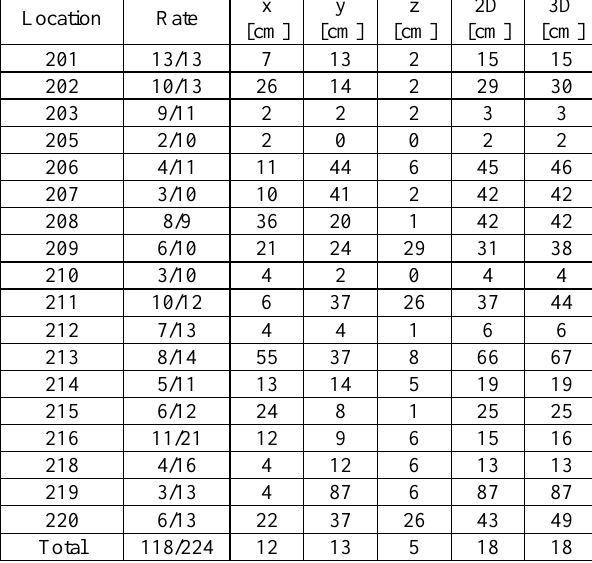
Table 4. Standard deviations of projection centres per location for our indoor environment